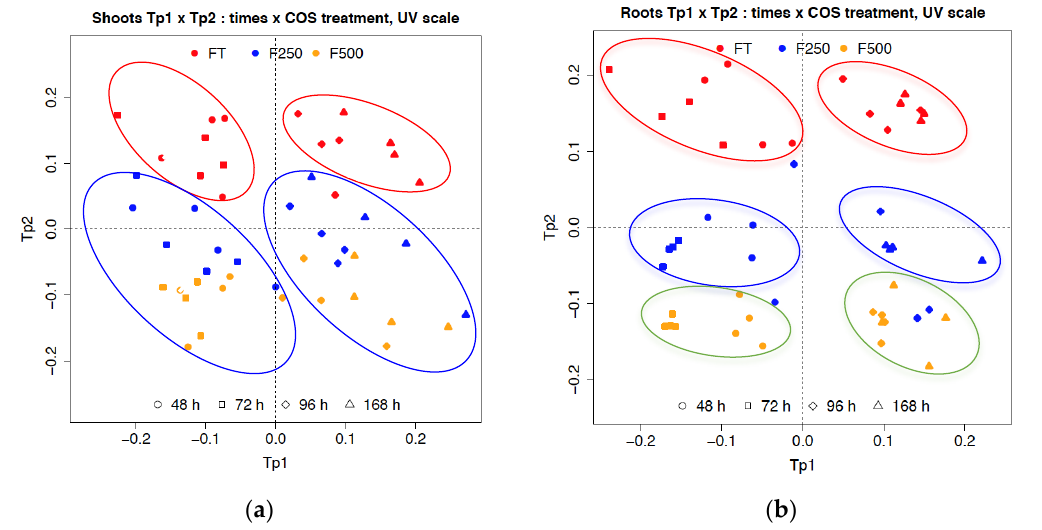
Figure 5. AMOPLS score plot: ( a ) shoots; ( b ) roots of flax seedlings from control (FT in red) and treated with COS solution (250 mg/L in blue and 500 mg/L in yellow) at four-time kinetic points (- - 48 h, - - 72 h, - - 96 h and - - 168 h).